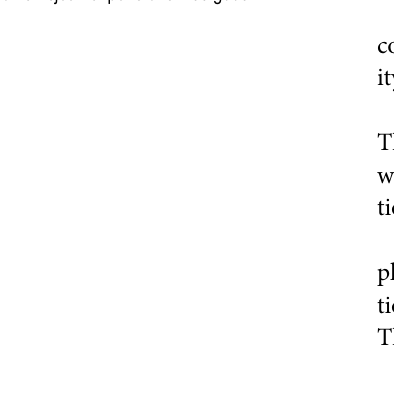
Fig 3. Histogram of Unigene clusters. The X-axis lists how many transcripts are in the unigene clusters, and the Y-axis lists show the number of unigenes clusters of that size.